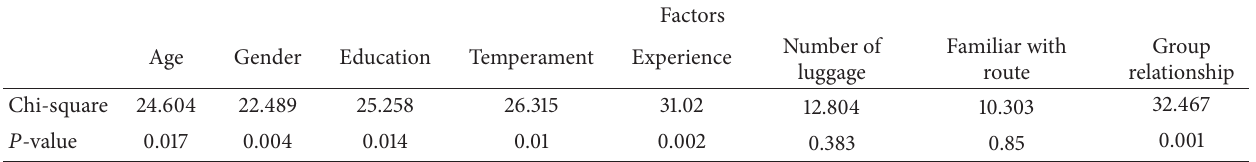
Table 1: Chi-square test for group decision-making with several